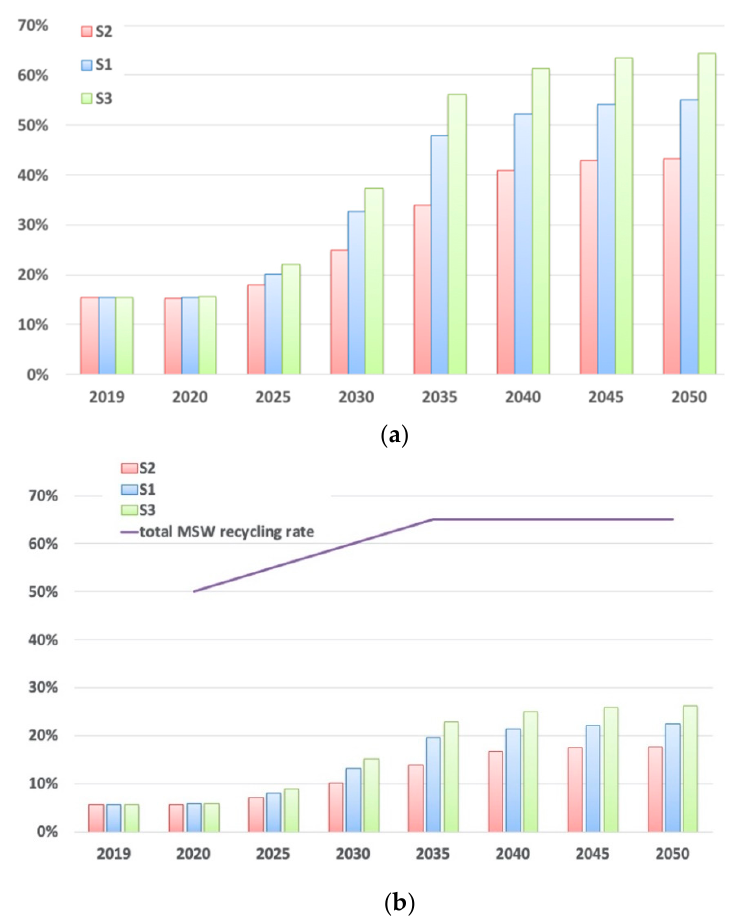
Figure 5. Biowaste separate collection scenarios.